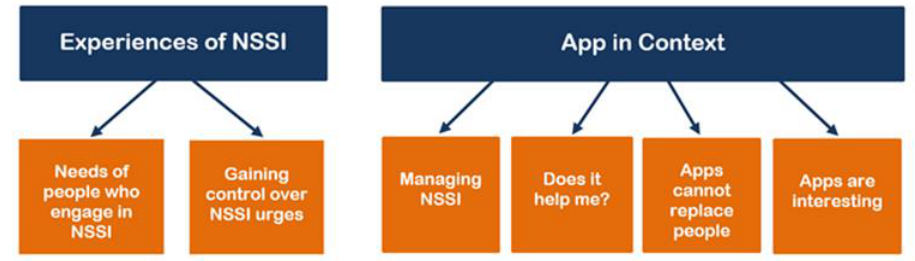
Figure 1. Thematic map representing themes and their subthemes. (NSSI = Nonsuicidal self-in- jury).